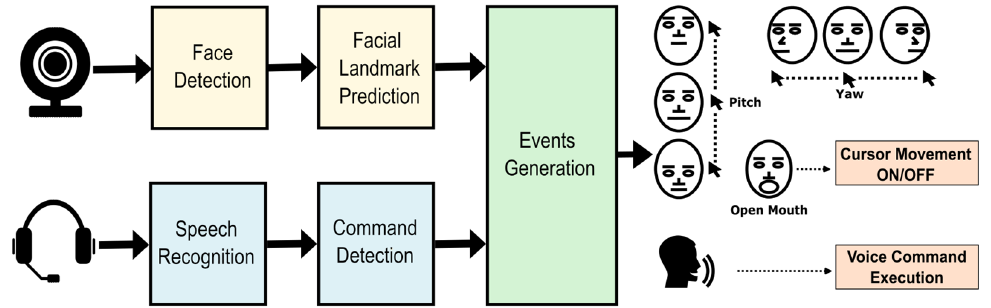
Figure 2. EMKEY block diagram.